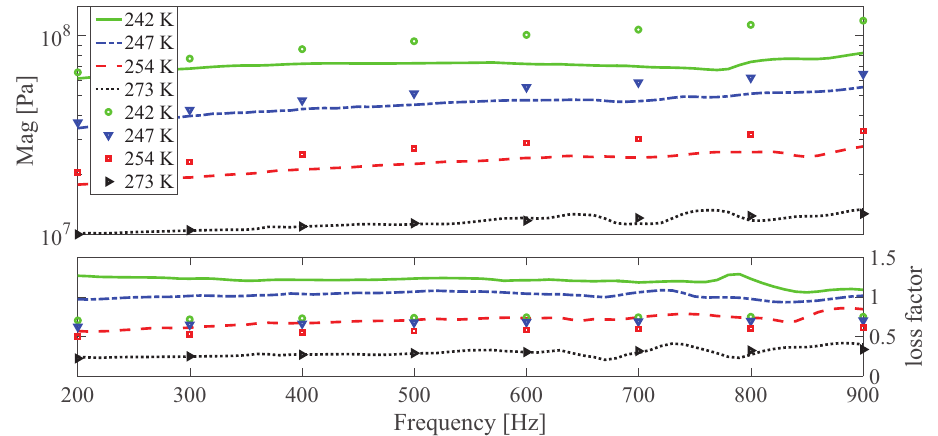
Figure 14. The magnitude and loss factor of the dynamic shear modulus versus frequency at 0.005 strain amplitude and 0T magnetic field under different temperatures. Lines and symbols are the simulation and measurement results,